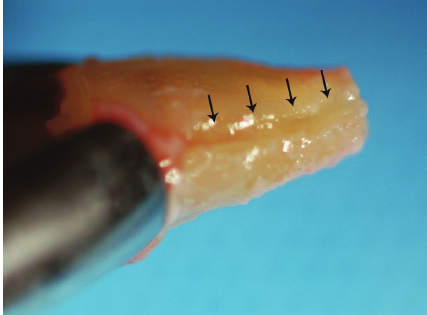
Figure 4: Arrows showing the shallow preparation of the fracture